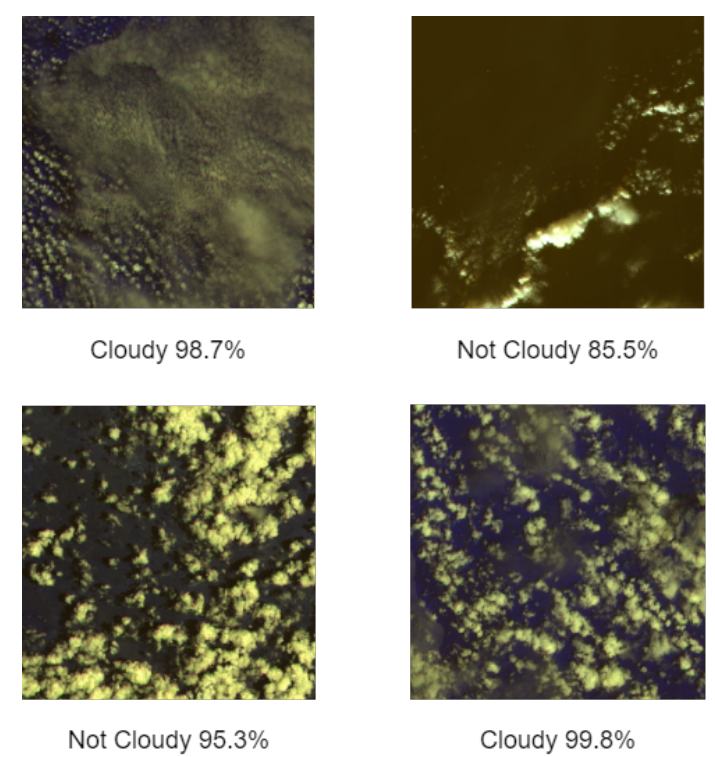
Figure 8. Examples of accelerator outputs. Input images are derived by Copernicus Open Access Hub